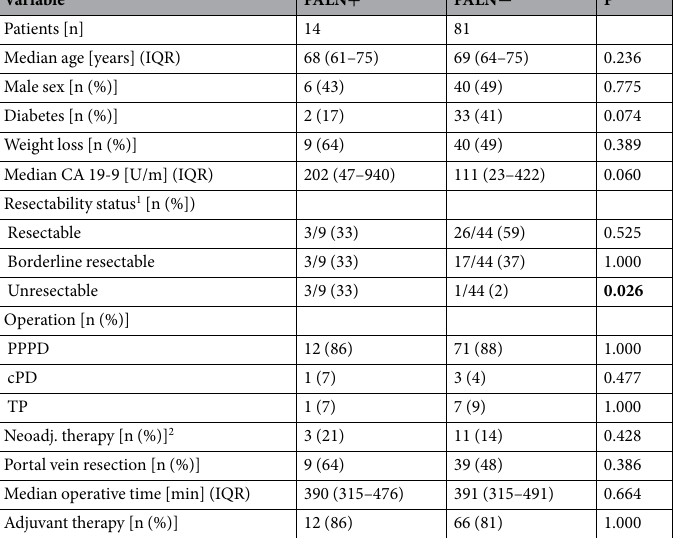
Table 1. Patient and operative characteristics. 1 The resectability status was assessed according to the National Comprehensive Cancer Network (NCCN) guidelines and was based on preoperative computed tomography scans (if available). 2 Neoadjuvant treatment regimen included chemoradiation or chemotherapy according to the FOLFIRINOX protocol; the latter being the current standard protocol in the neoadjuvant setting. Abbreviations: CA 19-9, carbohydrate antigen 19-9; cPD, classic pancreatoduodenectomy; IQR, interquartile range; neoadj., neoadjuvant; PPPD, pylorus-preserving pancreaticoduodenectomy; TP, total